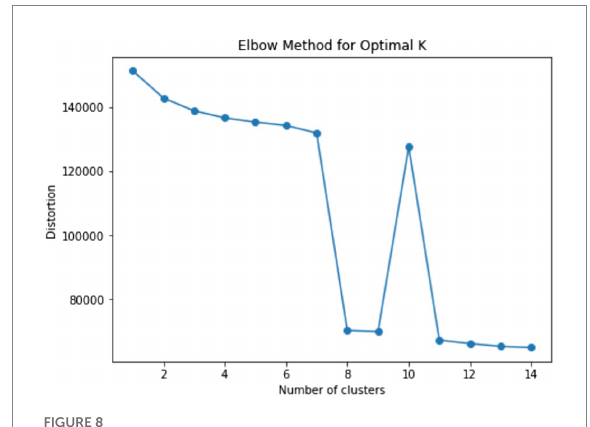
FIGURE 8 Result of elbow method for determining optimal k for students with incorrect